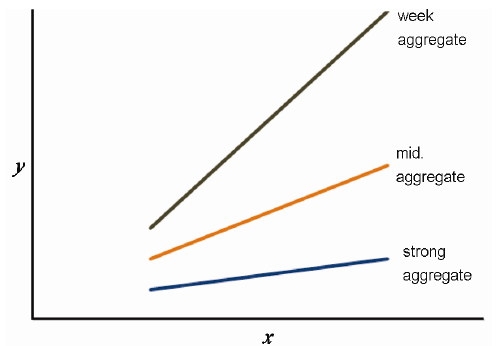
Fig. 2. Theoretical distribution of SZ, LA resistance values ac- cording to indexes FI and SI